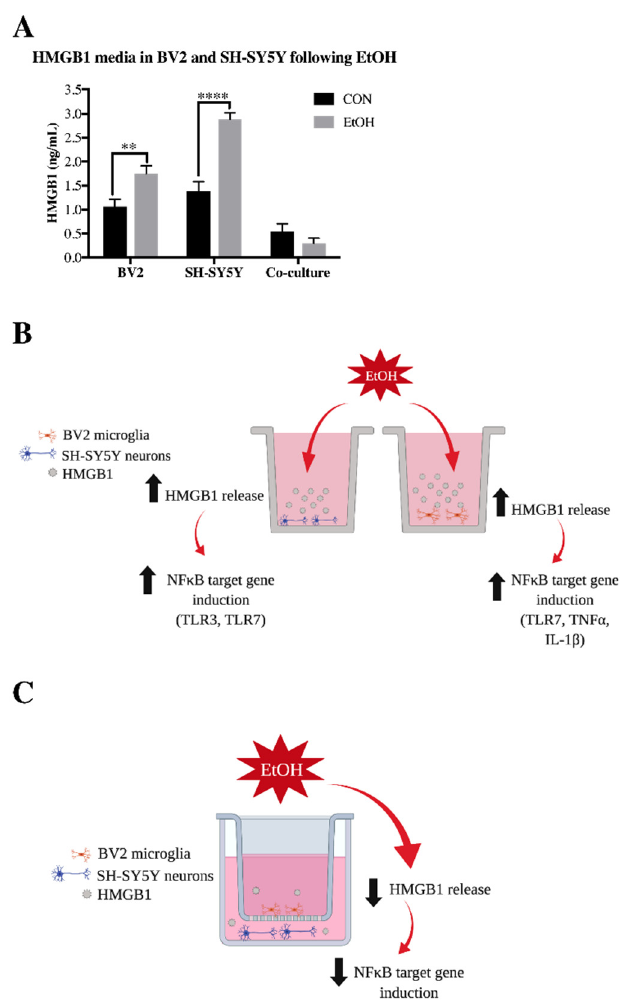
Figure 4. Co-culture blocks ethanol-induced HMGB1 release. BV2 microglia alone, SH-SY5Y alone and co-cultured BV2 / SH-SY5Y were treated with ethanol (EtOH, 100 mM) for 24 h. Media was collected and analyzed for high mobility group box protein 1 (HMGB1) protein using enzyme-linked immunosorbent assay (ELISA). ( A ) HMGB1 was increased in the media of EtOH-treated BV2 microglia and SH-SY5Y but not in co-cultured cells. ( B ) Schematic diagraming EtOH increasing HMGB1 release in BV2 and SH-SY5Y alone, leading to increased expression of NF κ B genes. ( C ) Schematic diagraming a lack of HMGB1 release in co-cultured BV2 and SH-SY5Y, preventing transcription of NF κ B genes. n = 5–6 wells per group; ** p < 0.01, **** p < 0.0001. Schematic made using Biorender (biorender.com).